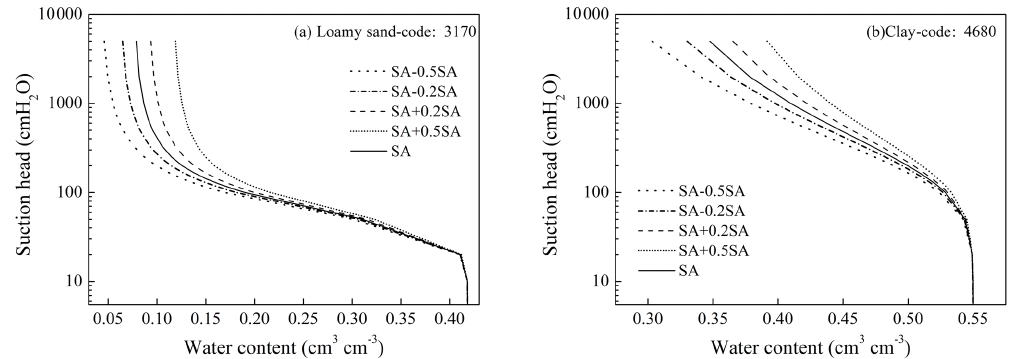
Figure 7. The effects of a change in the estimated S SA on the SWRC for loamy sand (code: 3170) and clay (code: 4680). The S SA denotes the accurate value of the specific surface area.